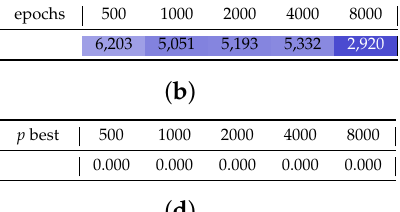
Figure A10. The test set I provides a sensitivity analysis on the number of shots s , with SPSA in the discriminator. ( a ) Converging runs, out of 10. ( b ) Number of epochs before convergence, on average. ( c ) p -value for the χ 2 test once convergence is reached (average over converging runs). ( d ) p -value for the χ 2 test once convergence is reached (best